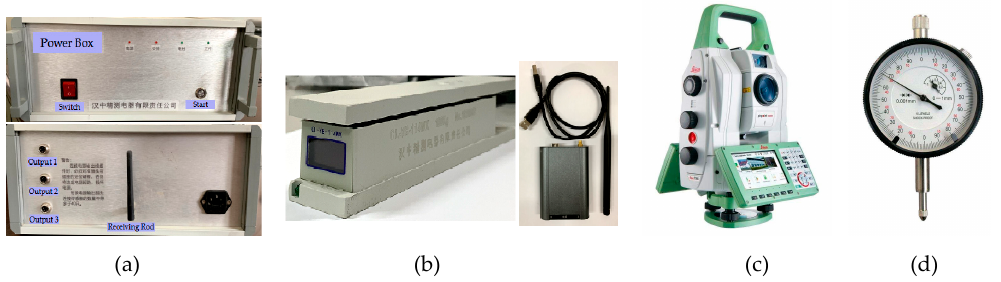
Figure 9. Experimental model diagram of similar simulation (Similarity ratio is 100).